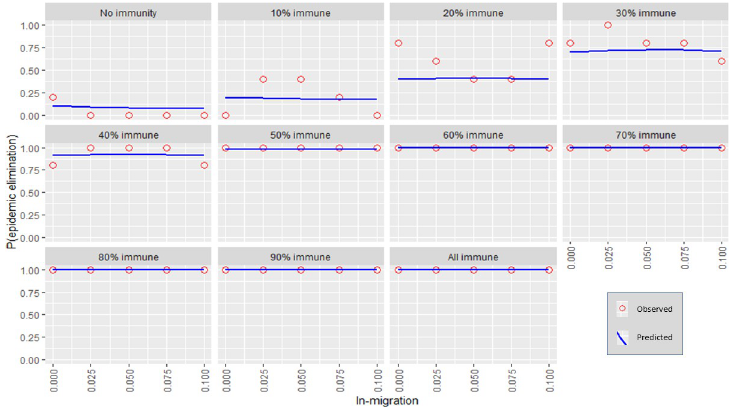
Fig 4. The response of P(elim.) to the in-migration rate at different herd immunities. The proportion of elimination events from the transmission model (red circles) and the prediction from the regression model (blue line).